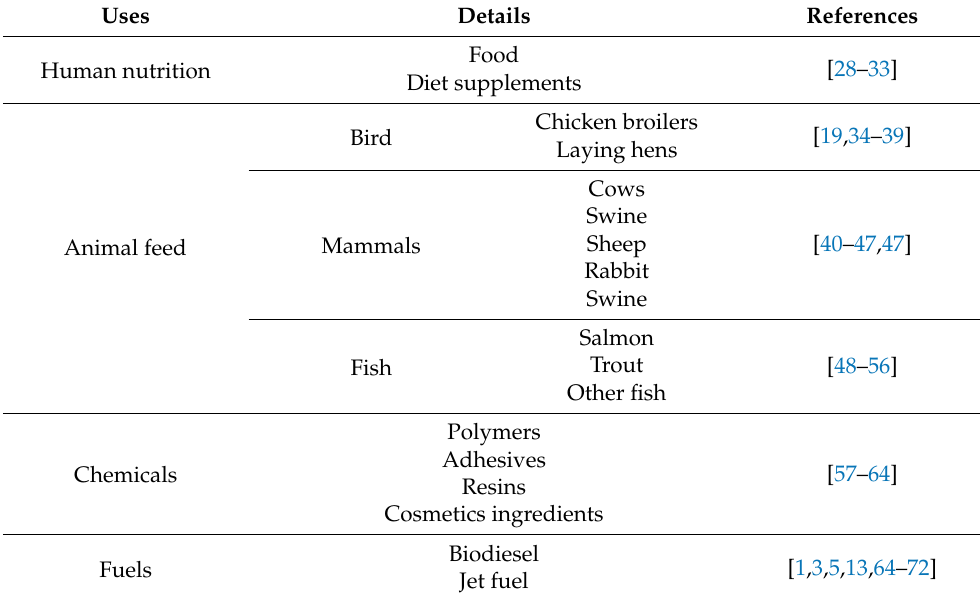
Table 1. Uses of Camelina sativa (modified from Berti et al., 2016 [3]).